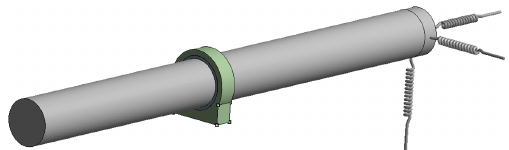
Figure 2. The three-dimensional finite-element model with double- row spherical-roller-bearing-type reaction